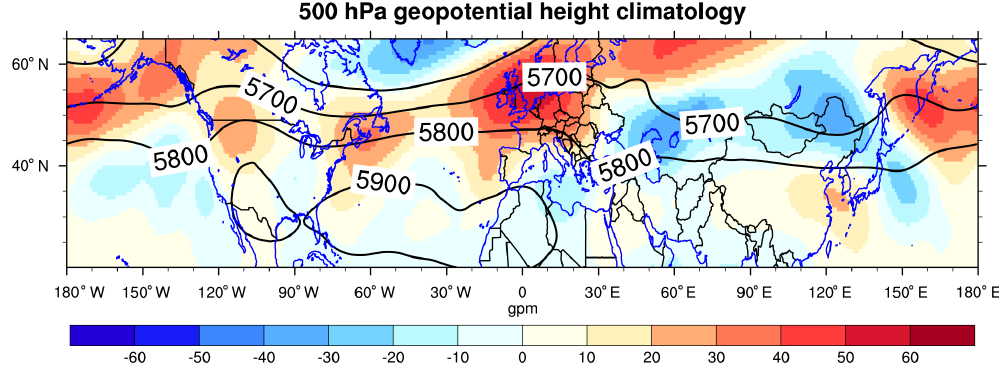
Figure 2. ERA-Interim 500hPa geopotential height climatology for July and August 2013 (black solid lines). The shaded areas show the anomaly during July and August 2013 compared to the period 1979–2012.